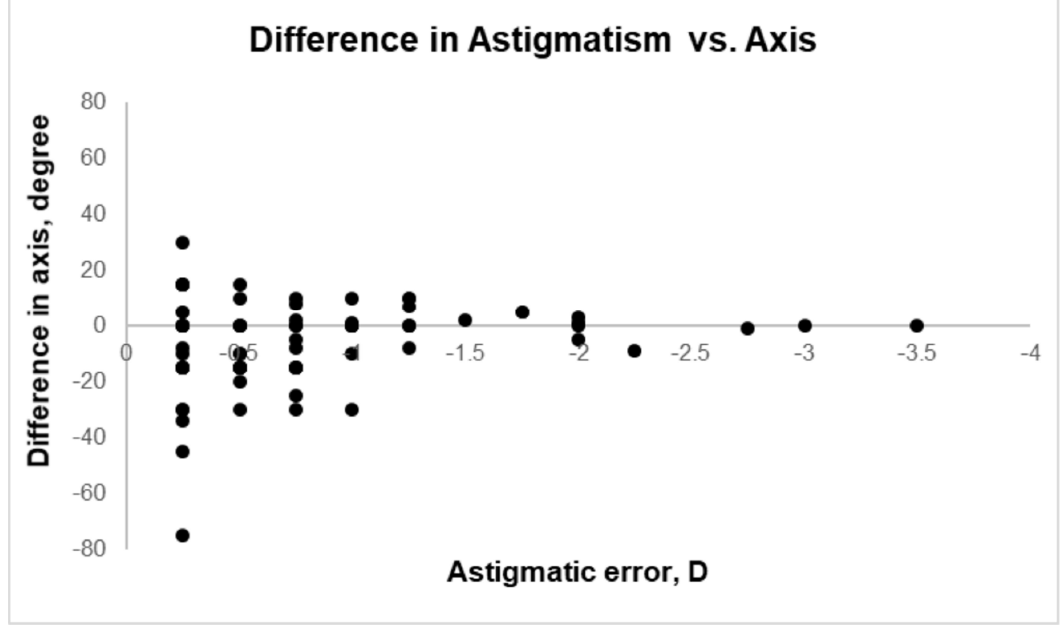
Figure 2. Difference of the cylinder-axis (deg) between Standard Refraction and Autorefraction as a function of the power of astigmatic error (D).